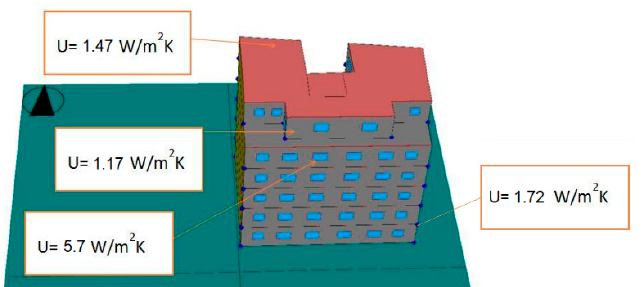
Figure 5. Energy modeling of one block of the building in its current state.